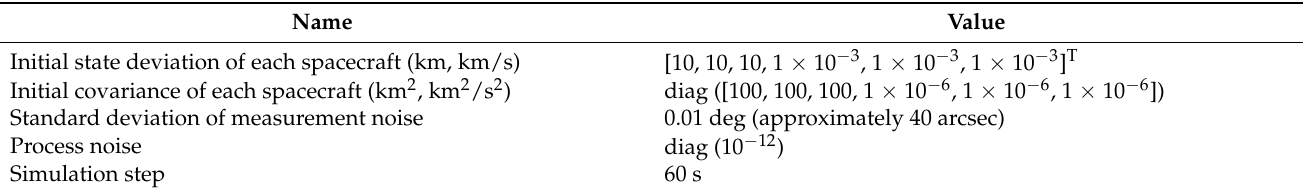
Table 3. Simulation parameters used in the UKF.